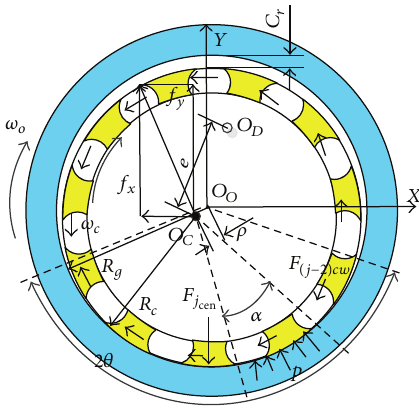
Figure 3: Forces generated by motion on the